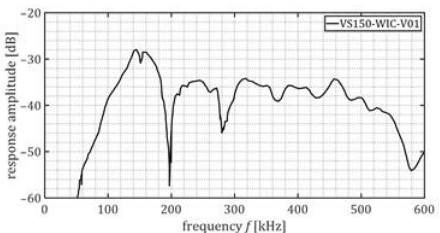
Figure 6. Transfer function of the piezoelectric AE transducers